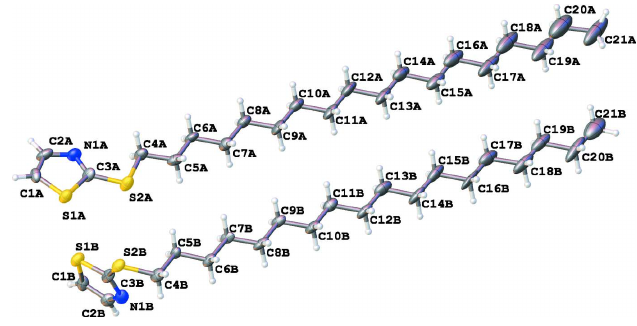
Figure 1 The title compound shown with 50% probability